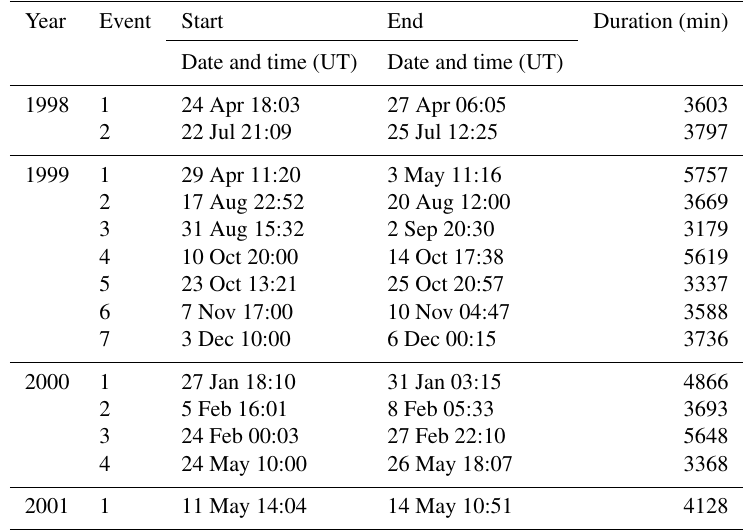
Table 1. Long-lasting AE events occurred between years 1998 and 2001 (Guarnieri, 2005).